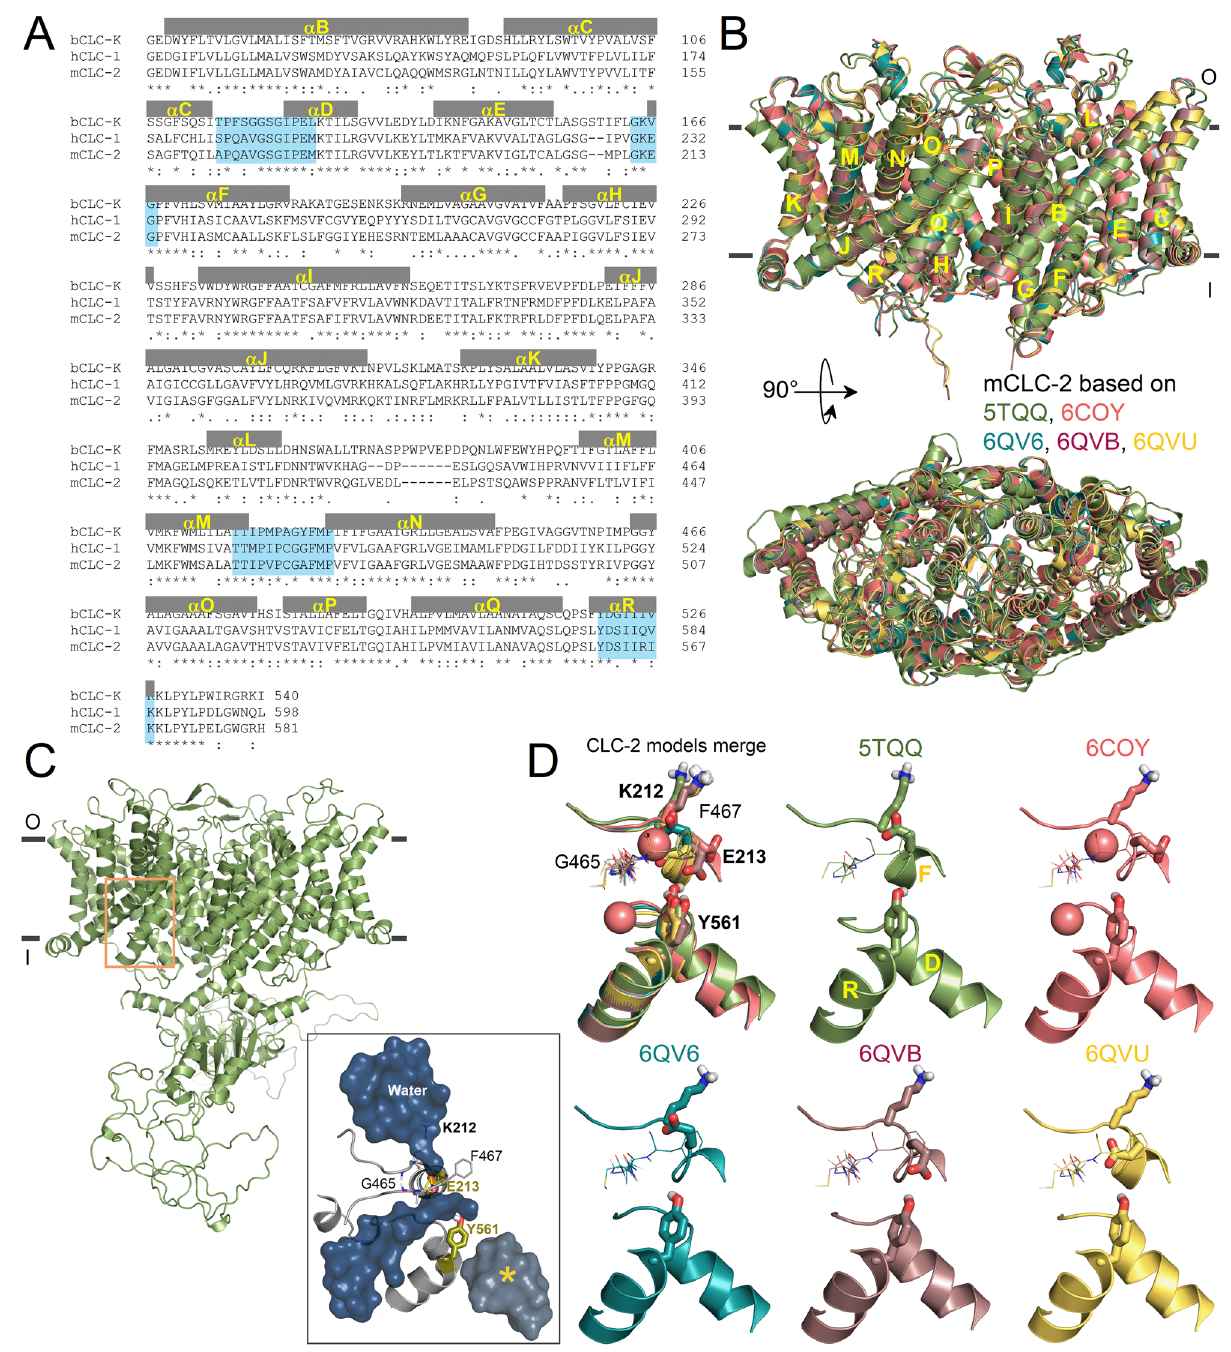
Figure 1. Homology models of the CLC-2 structure. (A) Sequence alignment of the transmembrane region of bovine CLC-K (bCLC-K), human CLC-1 (hCLC-1), and mouse CLC-2 (mCLC-2). Residues forming B-R alpha helices are shown in grey and pore region residues are highlighted in blue. (B) Structural alignment of the homology models for the CLC-2 structure. Homology structures were built using the cryo-EM structure of CLC-K (5TQQ, green) and hCLC-1 (6COY, salmon; 6QV6, cyan; 6QVB, redwood; 6QVU, yellow) channels as templates. Views of the transmembrane domains (yellow letters) perpendicular to membrane plane (above) and from the top (below). Parallel grey lines indicate external (o) and internal (i) membrane limits. The RMSD of backbone atoms were < 0.31 Å and the C-score = 1.98 calculated by I-Tasser (2 is the upper limit). (C) mCLC-2 CLC-K model structure showing the transmembrane and intracellular cystathionine-β-synthase (CBS) domains. The external and internal membrane limits are indicated by parallel grey lines. The orange square indicates the intracellular pore region shown in (D) . Grey square shows the canonical pore flooded with water represented as a dark surface. The intracellular alternative pathway, unconnected to the canonical pore, is shown in grey marked with a yellow asterisk. Y561 and E213 are in olive. (D) Pore region of mCLC-2 models. Pore regions superposition (CLC-2 models merge) from homology structures. Sticks represent K212, E213, and Y561. The sidechain of E213 adopted different positions depending on the template; away from Y561 in 5TQQ, 6COY, and 6QV6 based models and closer to Y561 in 6QVB and 6QVU based models. Chloride ions (pink spheres) from hCLC-1 6COY were placed in the 6COY-based CLC-2